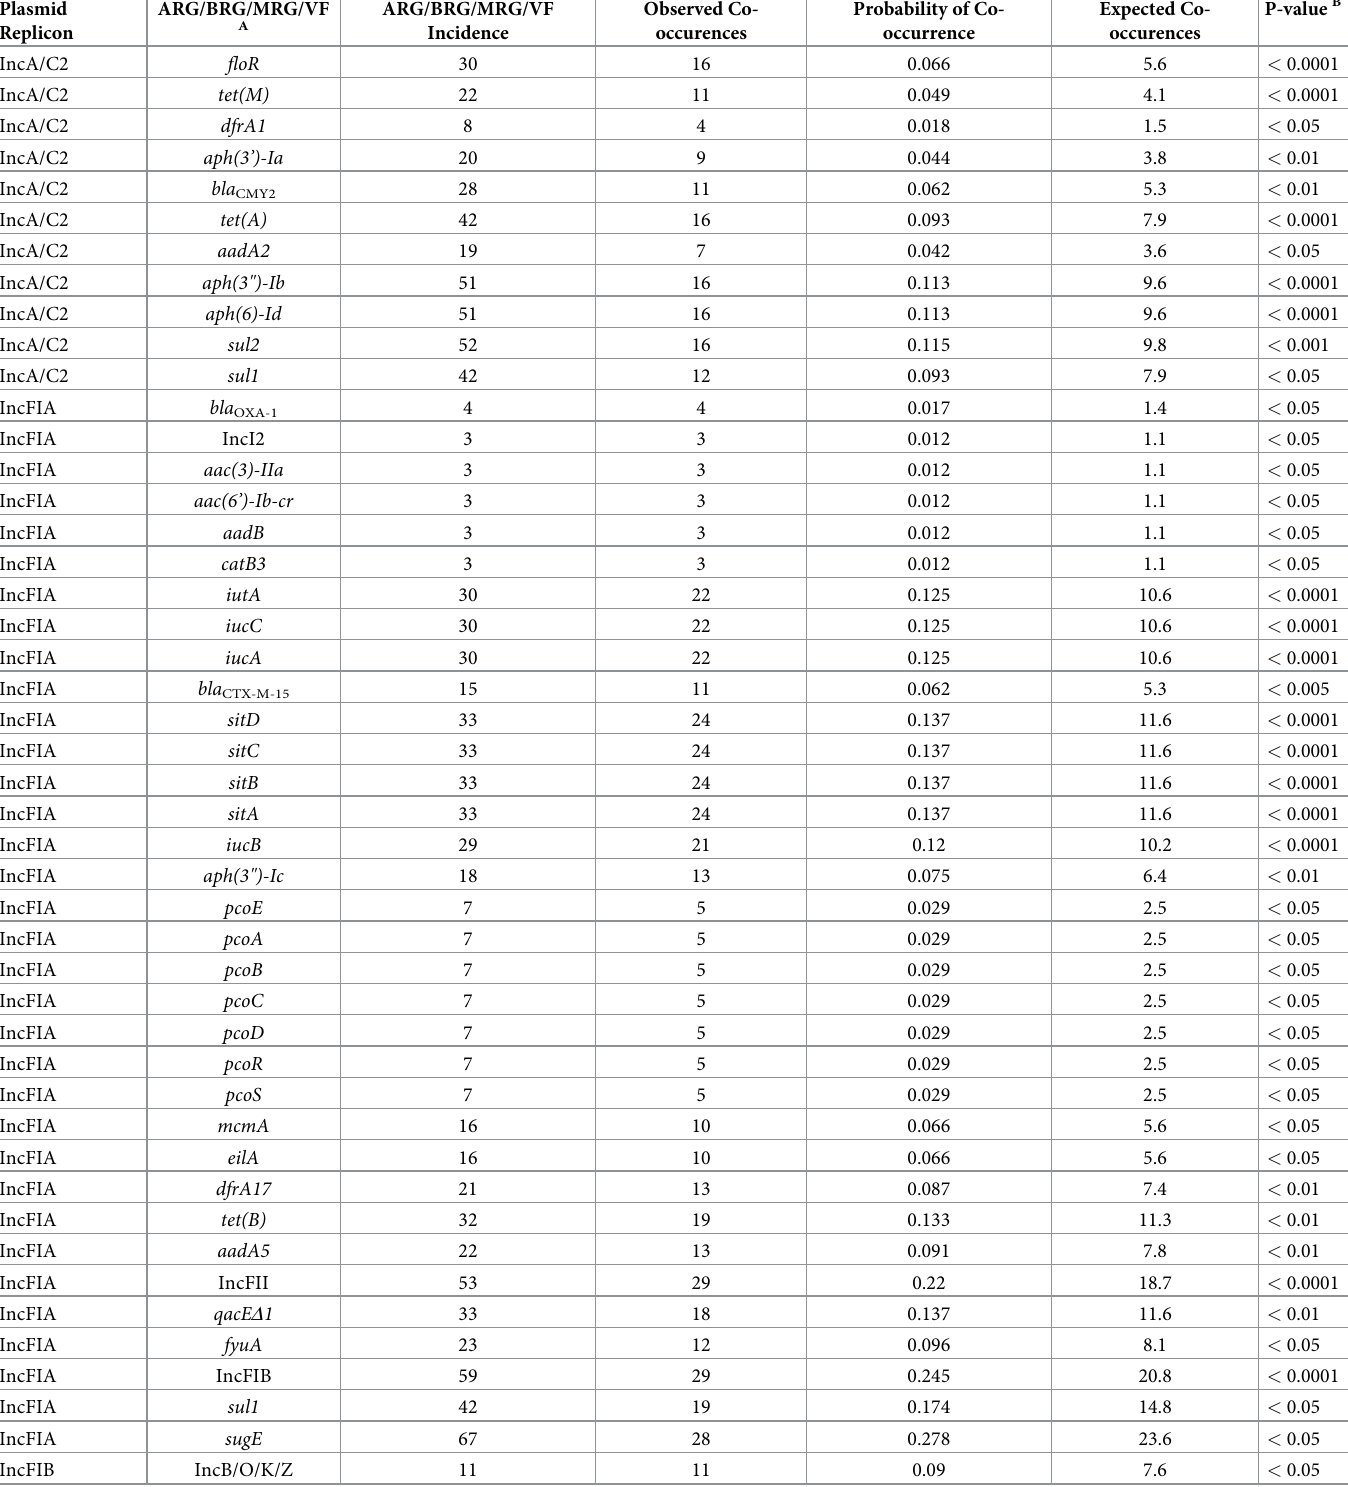
Observed Co- occurences